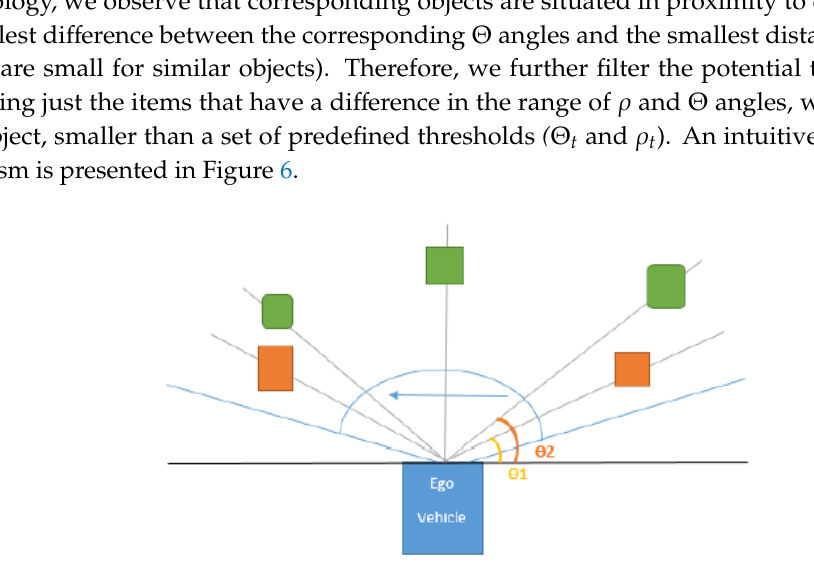
Figure 7. Results of LIDAR object to trifocal object association. On the left-hand side, the color image of the recorded scene is displayed. On the right-hand side, the processed sensory data containing trifocal and LIDAR objects are shown.